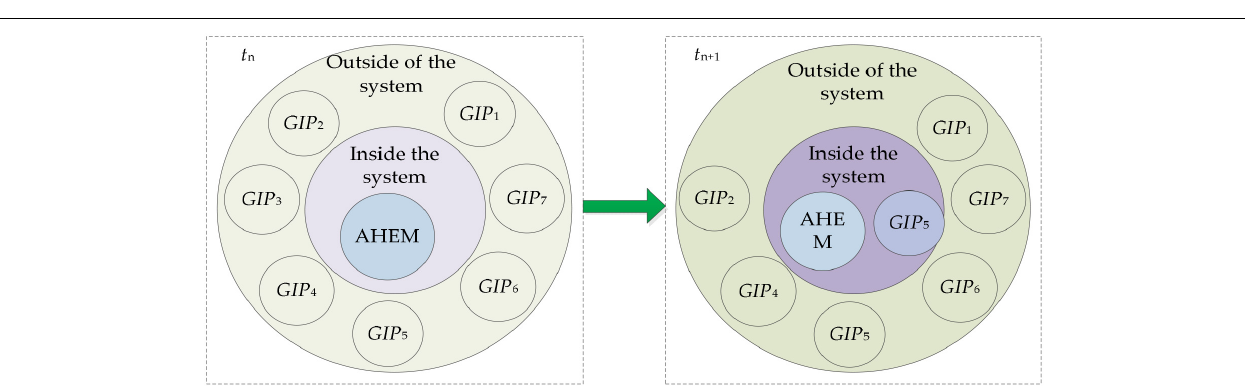
FIGURE 5 | The dynamic selection